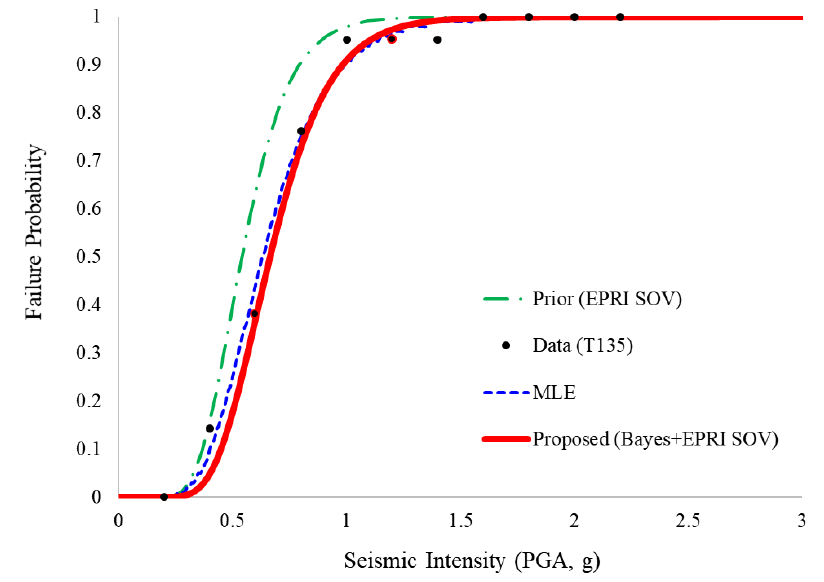
Figure 12. Piping seismic fragility curve regarding a limit state of seismically vulnerable T-joint